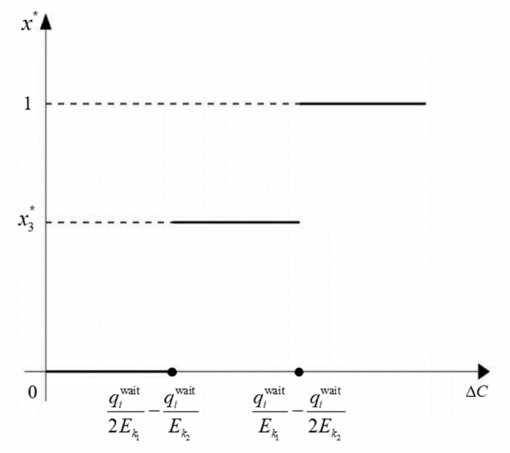
Figure 3. Distribution of x ∗